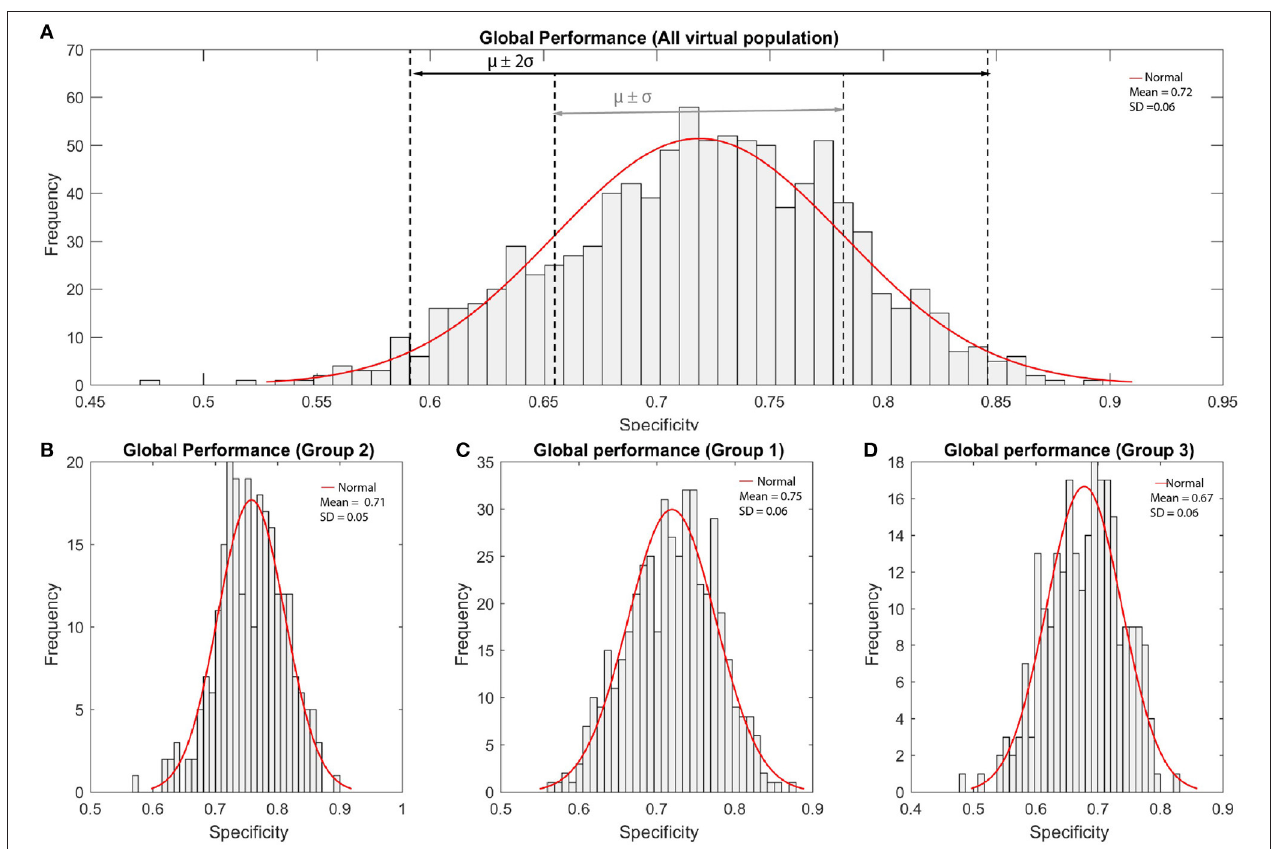
FIGURE 5 | Histograms of global performance of a population of virtual patients. (A) All virtual population, (B) Group 2 ( − 1 standard deviation) (C) Group 1 (mean value) and (D) Group 3 ( + 1 standard deviation).